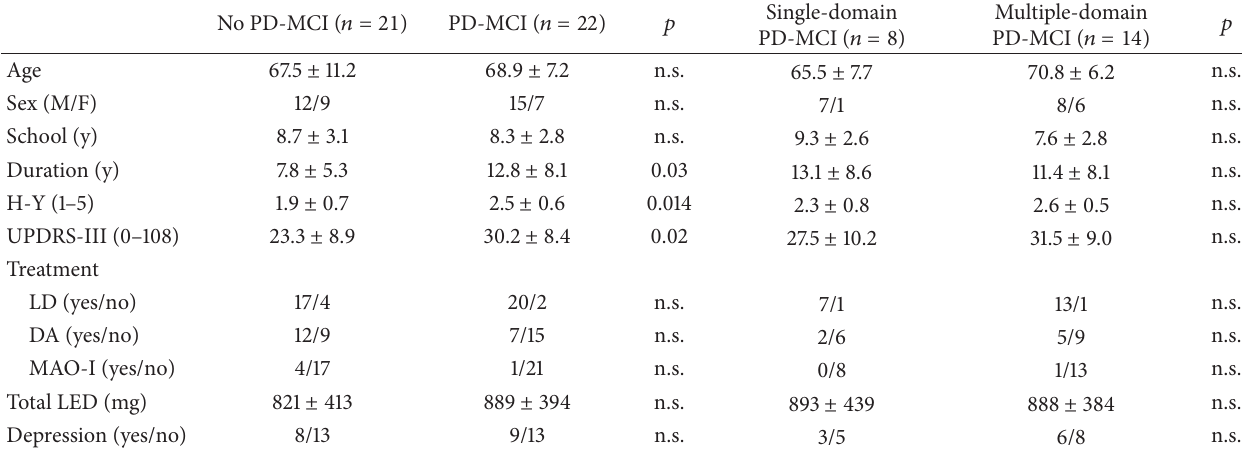
Table 2: Characteristics of patients, according to the diagnosis and subtype of PD-MCI (MDS Task Force level II criteria). No PD-MCI ( 𝑛 = 21